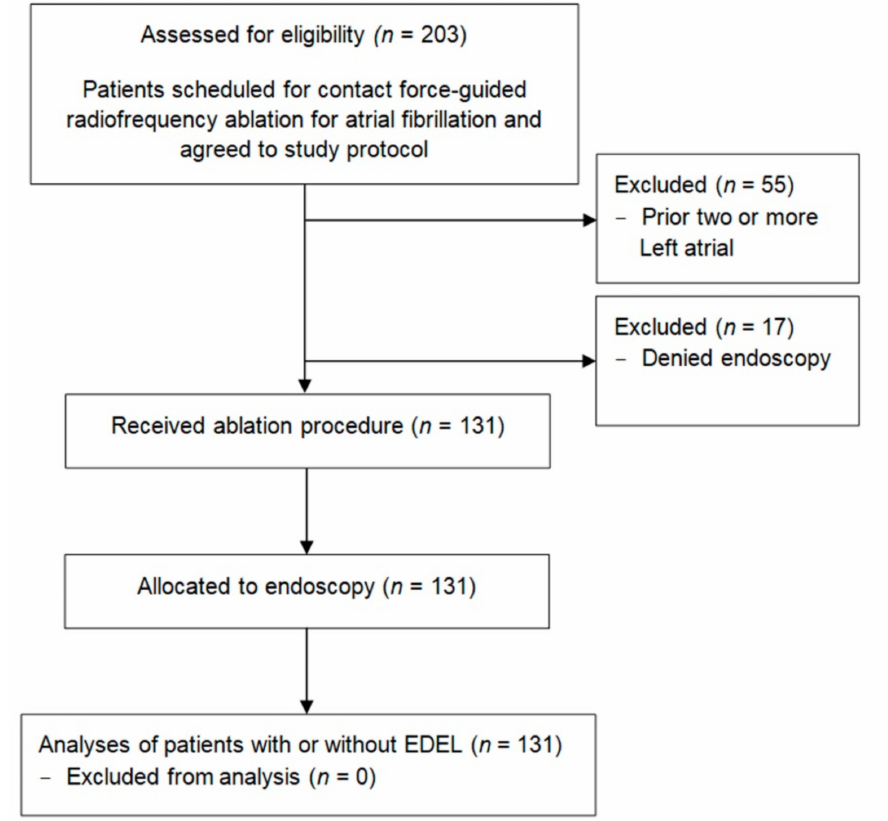
Figure 1. Patient enrollment. CF indicates contact force; RF, radiofrequency; LAT, left atrial tachycar- dia; LA, left atrial and EDEL, endoscopically detected esophageal